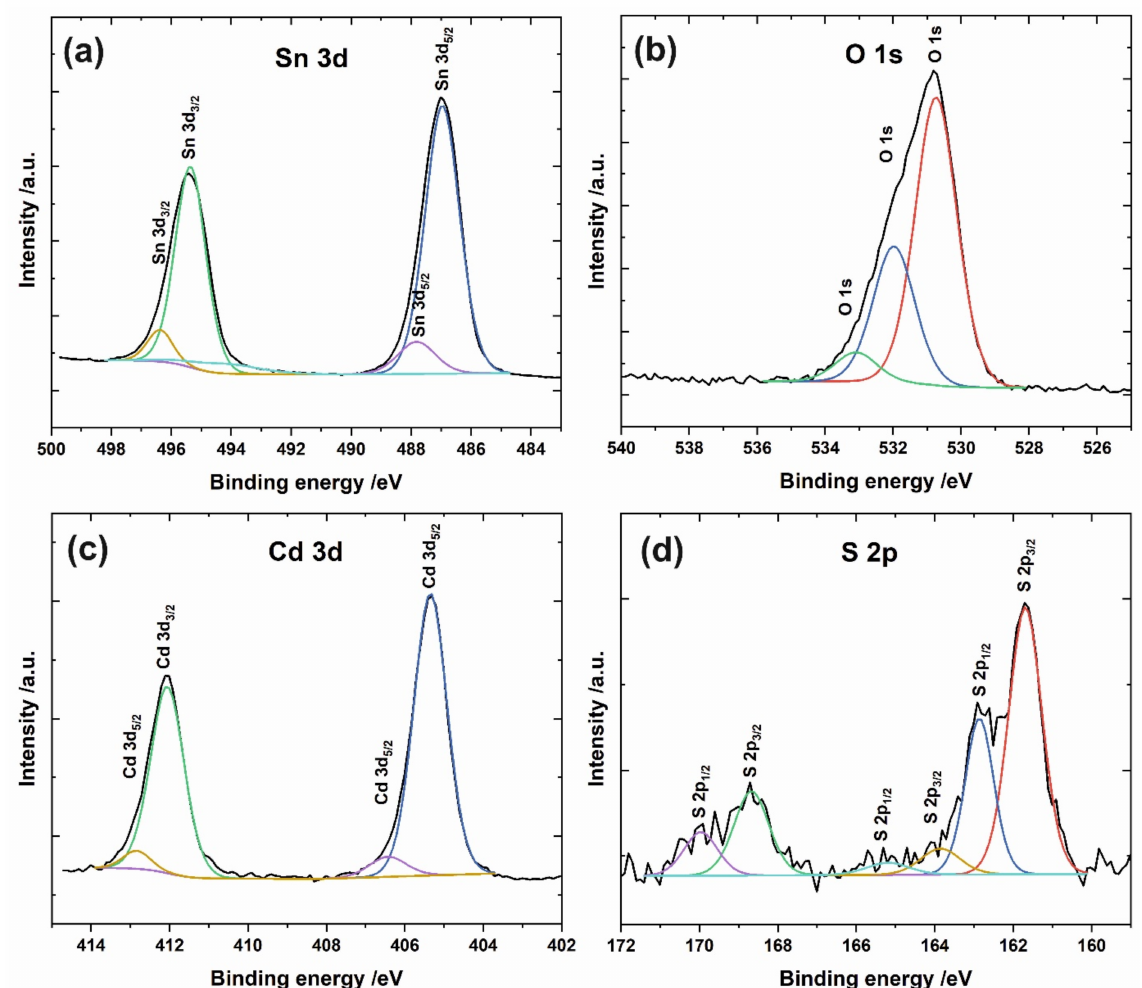
Figure 3. High-resolution XPS spectra of Sn 3d ( a ), O 1s ( b ), Cd 3d ( c ), and S 2p ( d ) recorded for the a/a